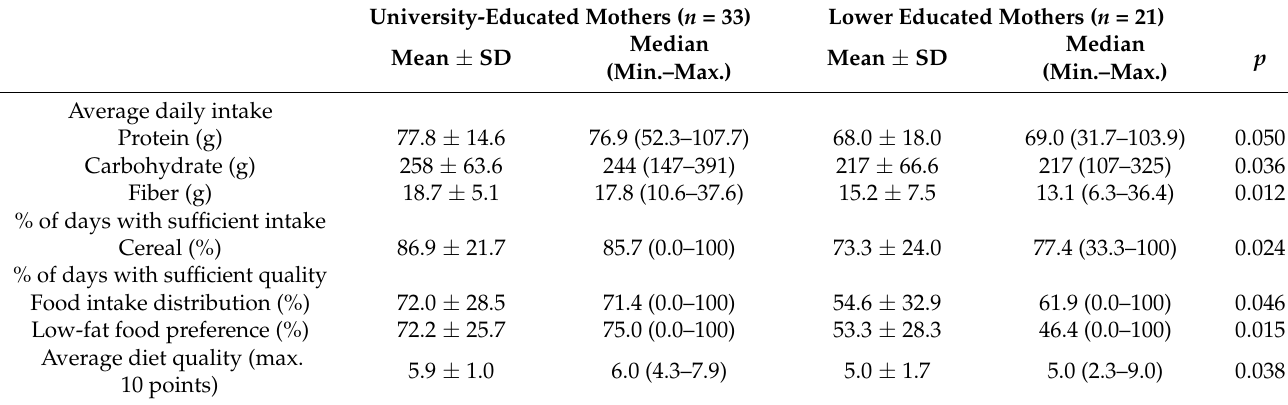
Table 3. The relationship between diet quality and education.